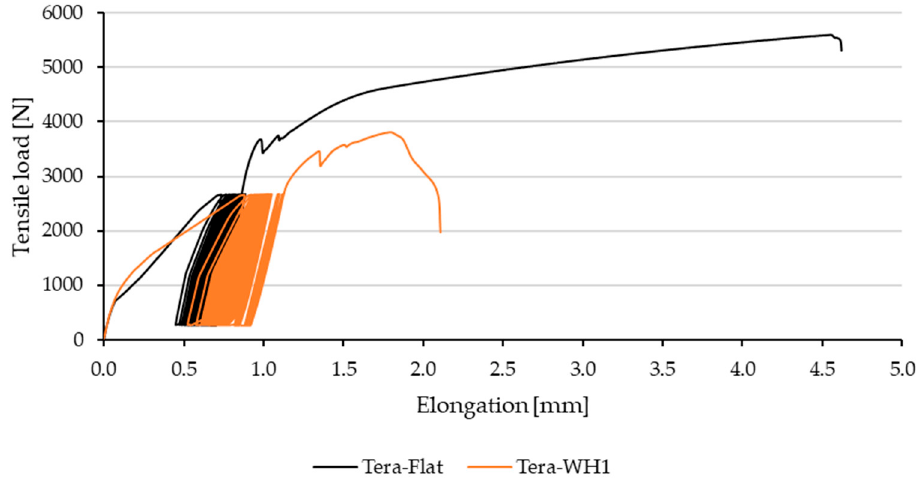
Figure 8. Viscoelastic behavior of adhesive bonds with reinforcing fabric Erik and different shapes during 5–50% cyclic load.